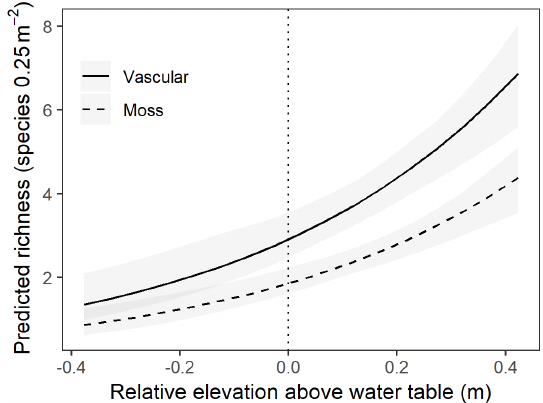
Figure 4. Predicted understory species richness as a function of ele- vation above the mean water table based on the GLMM without ran- dom site effects included, split by moss and vascular species com- ponents. Shaded ribbons indicate 95% confidence intervals about the estimate.